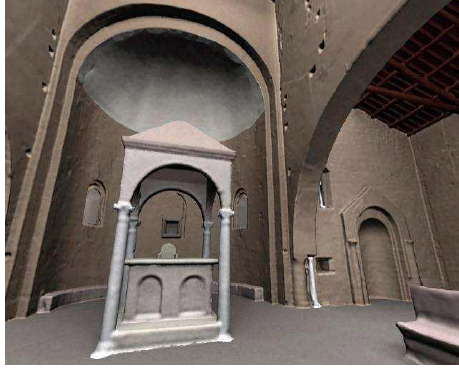
Figure 8. The apse and his surrounding actual shape